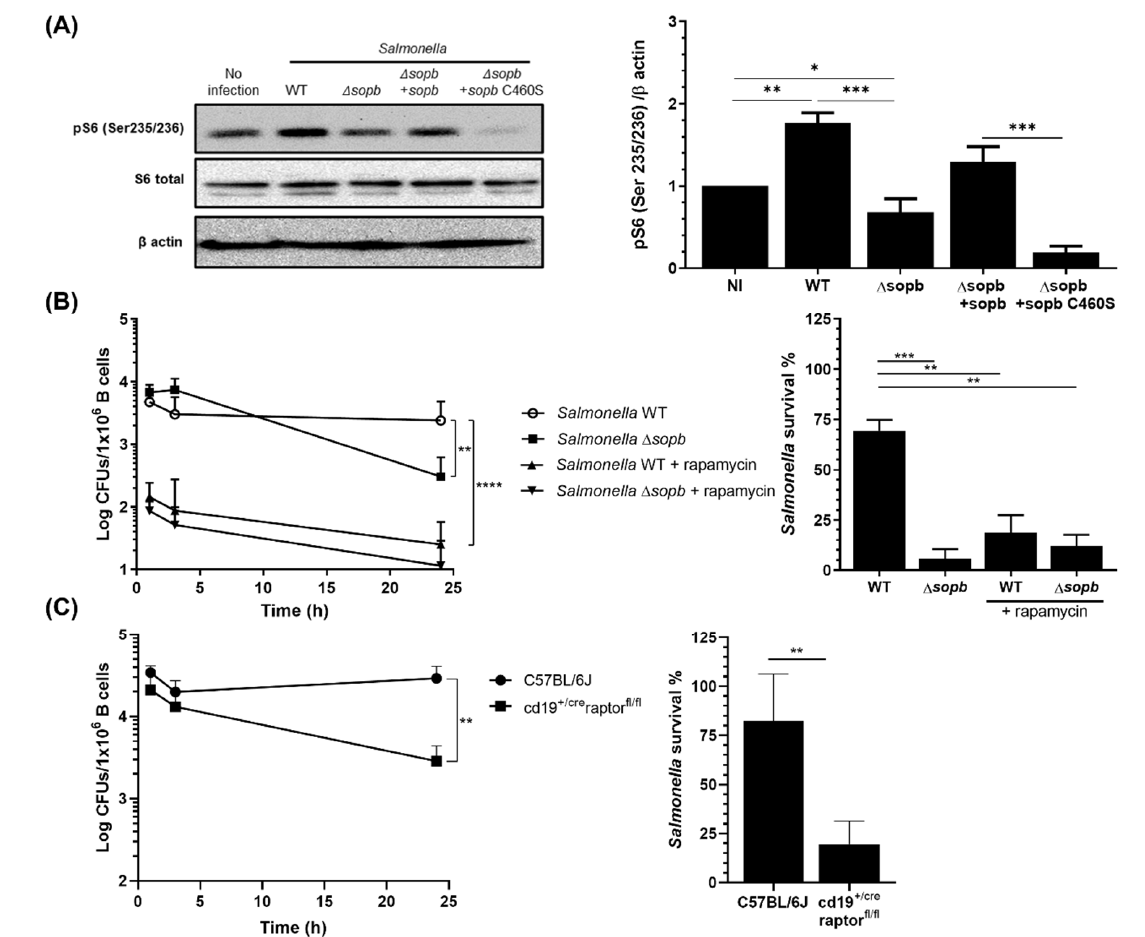
Figure 2. SopB activates mTORC1 to promote the survival of Salmonella in B cells. ( A ) mTORC1 activation was measured by pS6 (S235/S236) levels in B cells infected at a MOI of 50 with different strains of Salmonella . Total levels of 6S are shown. Data were normalized based on loading control and non-infected B cells. ( B ) CFUs recovered from B cells treated or not with the mTOC1 inhibitor rapamycin (160 nM) and infected at a MOI of 50 with S . Typhimurium WT or ∆ sopb. ( C ) CFUs recovered from C57BL/6J or cd19 +/cre raptor fl/fl (mTORC1 KO) mouse B cells infected with Salmonella WT for 24 h. The percentage of Salmonella survival in ( B ) and ( C ) was calculated by dividing CFUs recovered at 24 h between CFUs recovered at 1 h. Results are expressed as means ± SDs. n = 3. A two-way ANOVA test was used for multiple comparisons and an unpaired Student’s t -test was used for bars. * p < 0.05, ** p < 0.01, *** p < 0.001 and **** p <